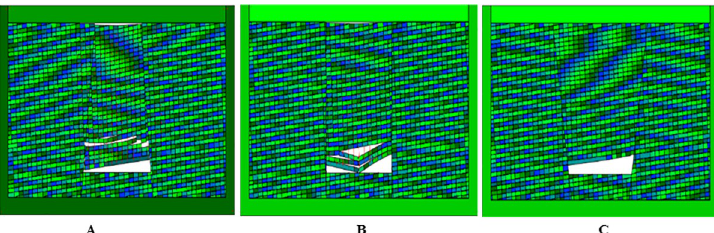
Fig 14. Simulated operation at 3200 time step. (A) Inverted funnel. (B) Columnar. (C) Funnel.